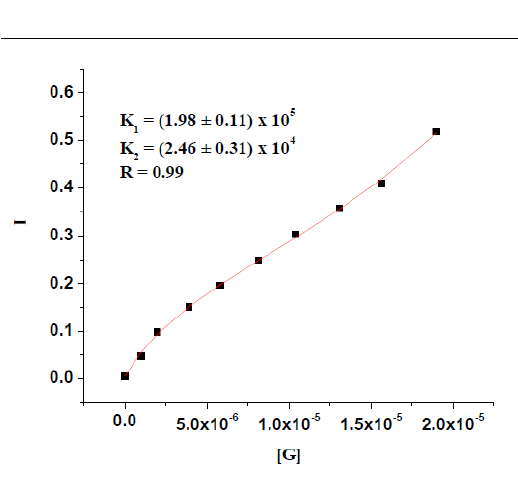
Scheme 8: Probable binding mode of the receptor with acetate.